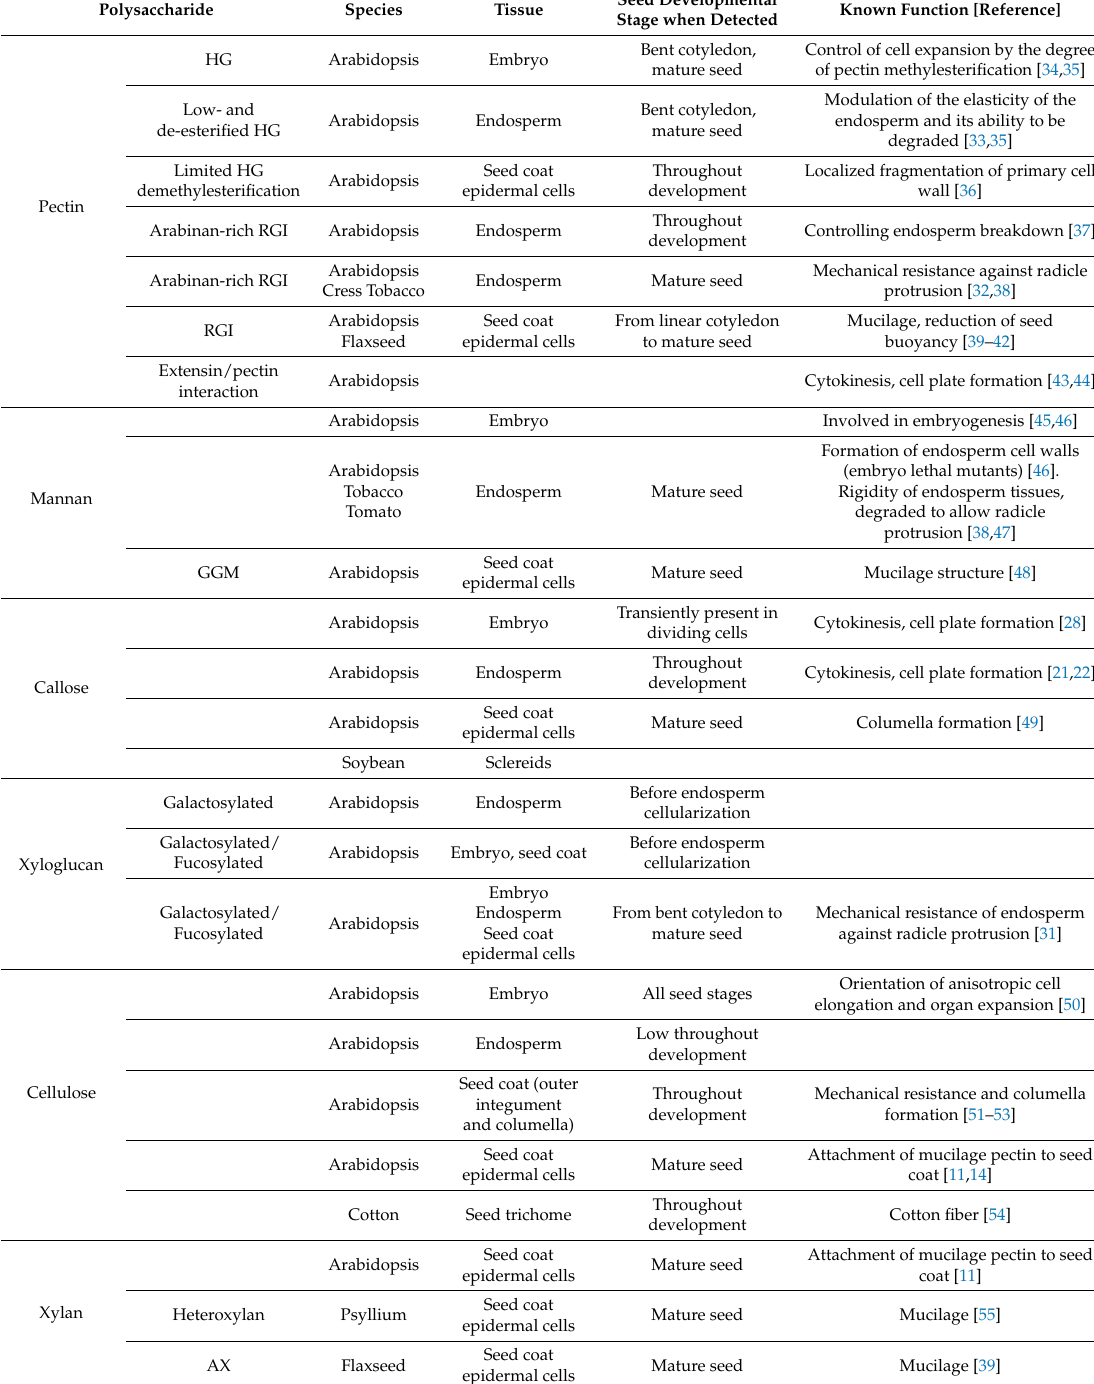
Table 1. Summary of cited data concerning the localization and function of cell wall polysaccharides during seed